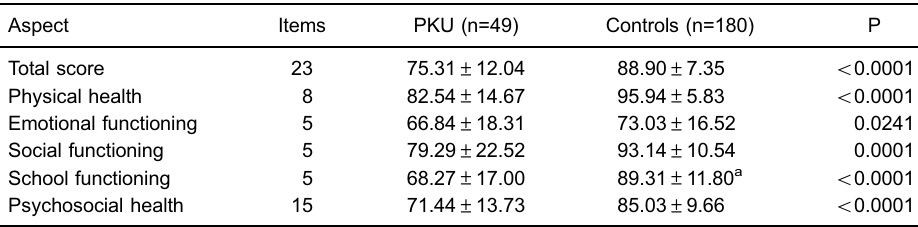
Table 1. Self-reported scores for PedsQL 4.0 generic core scales of Brazilian early-treated phenylketonuria (PKU) pediatric patients. Aspect